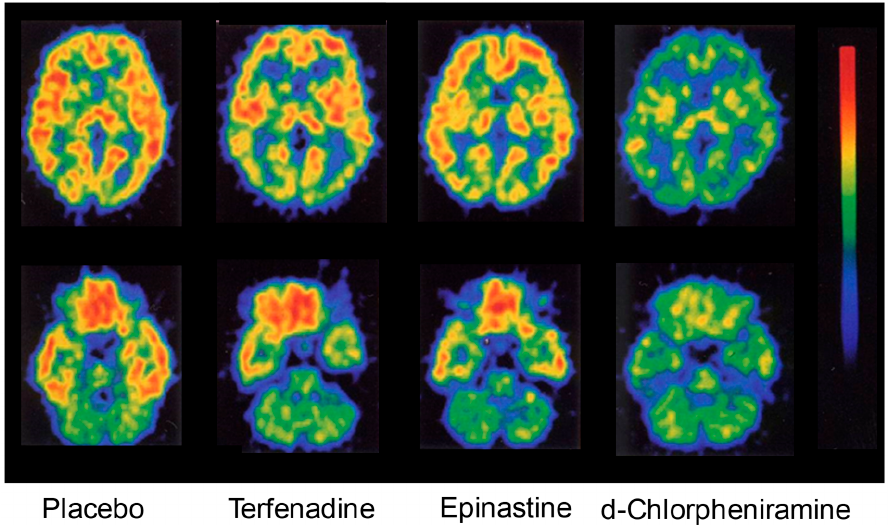
Figure 1. Early studies on positron emission tomography (PET) measurements of brain histamine H 1 receptor occupancy. These images show radioactivity in horizontal brain sections at the striatal level (upper) and the cerebellar level (lower) after intravenous injection of [ 11 C]doxepin into healthy volunteers. Terfenadine (60 mg), epinastine (20 mg), or d-chlorpheniramine (2 mg) was orally administered 1 h before the doxepin injection. For example, d-chlorpheniramine clearly decreased the accumulation of the [ 11 C]ligand in the brain, resulting in a histamine H 1 receptor occupancy of 76.8%. The brain histamine H 1 receptor occupancy (%) was defined and calculated as described [18]. Modified based on [18].